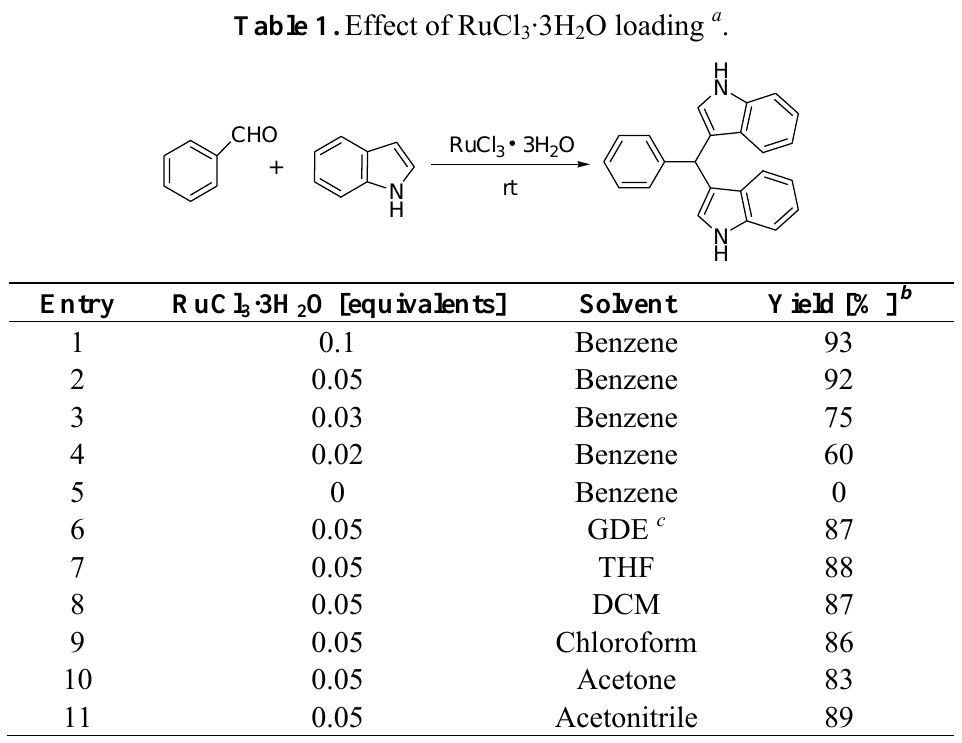
·3H O loading a 3 2